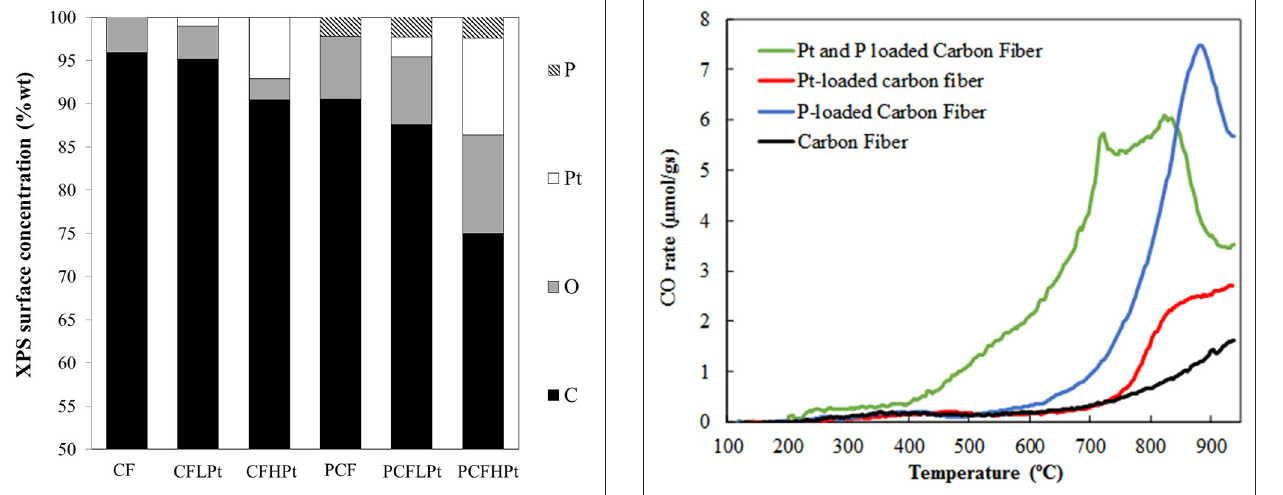
FIGURE 9 | Weight surface concentration of carbon fibers obtained by XPS. FIGURE 10 | CO-TPD profiles for pure and Pt-containing carbon fibers. Heating rate: 20 ◦